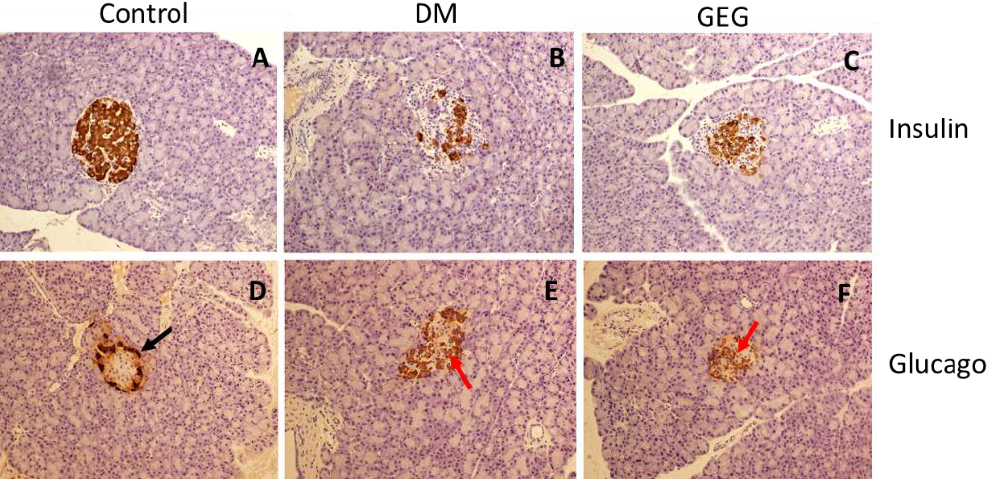
Figure 4. Effect of gingerol-enriched ginger (GEG) on immunohistochemical analysis of pancreatic tissue. Pancreatic tissue sections collected from the Control group ( A , D ), DM group ( B , E ), and GEG group ( C , F ) were immunostained for insulin ( A – C ) or glucagon ( D – F ) and counterstained with hematoxylin. The black arrow in ( D ) indicates alpha cells in the normal orientation along the outer edge of the islet, while the red arrows in ( E , F ) indicate alpha cells localized to the center of the islet. n = 6 – 8 per group. IHC magnification 20×.